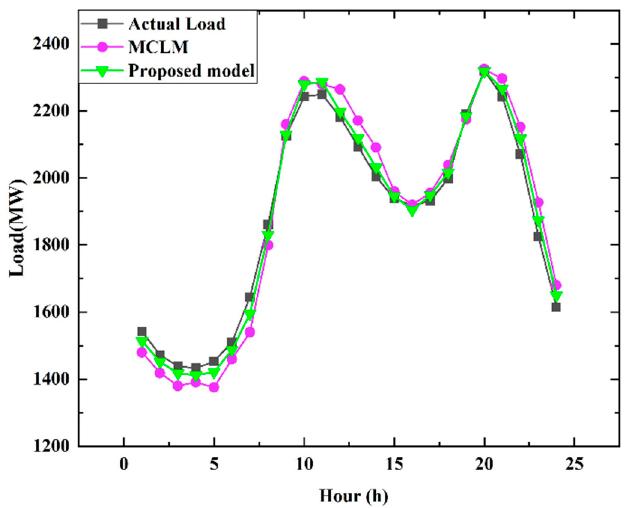
Figure 6. Comparison of forecasting result and actual load between the proposed model and other deep learning methods over one day. deep learning methods over one